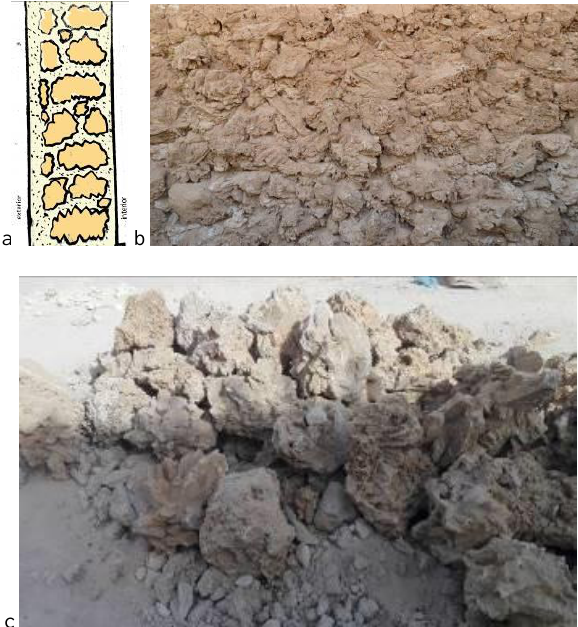
Figure 8. a. Section of ‘Desert Rose’ stone masonry. b. Wall of masonry building. c. Big ‘Desert Rose’